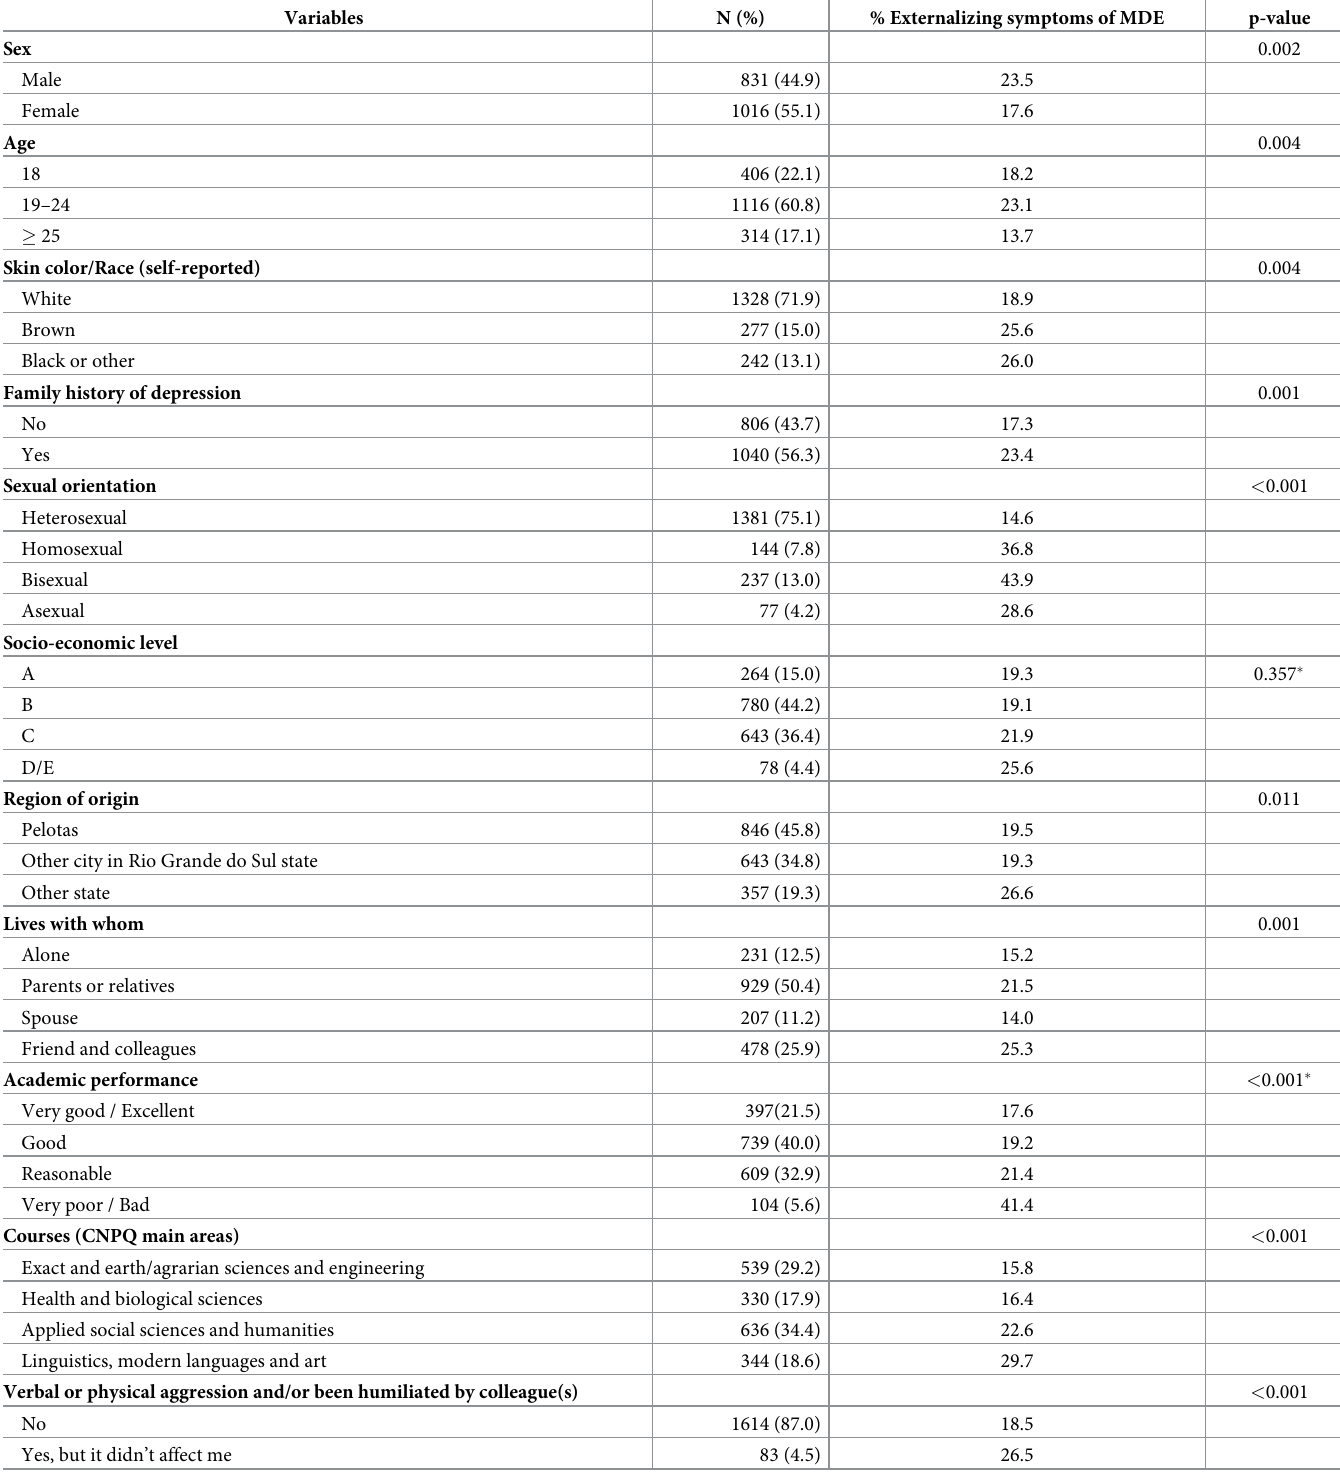
Table 1. Sample description according to demographic, socio-economic and academic characteristics and prevalence of externalizing symptoms of Major Depres- sive Episodes (MDE) among university students. Pelotas (RS), Brazil, 2017 (n =